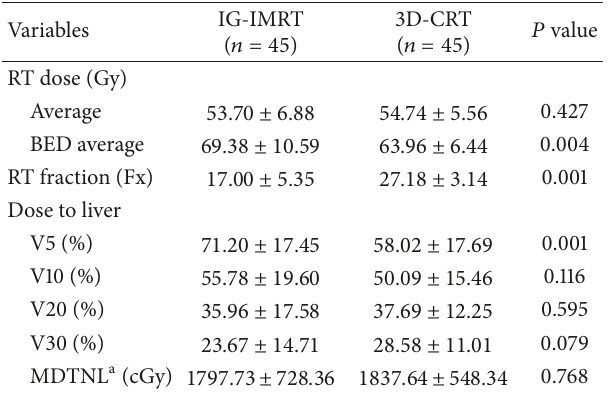
Figure 2: PFS rates of target lesions according to the modality of radiotherapy. The IG-IMRT group had a significantly longer median progression-free survival time of target lesions ( 𝑃 = 0.021 ). The Figure 1: Correlation between GTV and BED. Correlation analysis median progression-free survival in the IG-IMRT group and the showed that the prescription dose was negatively correlated with 3D-CRT group was 15.41 ± 1.51 months and 8.26 ± 1.00 months, GTV. The correlation coefficient was −0.431 ( 𝑃 < 0.001 ). respectively. The 1- and 2-year progression-free rates were 68.5% and 20.3% in the IG-IMRT group and 41.4% and 16.9% in the 3D-CRT group, respectively. Table 2: Dose distribution.